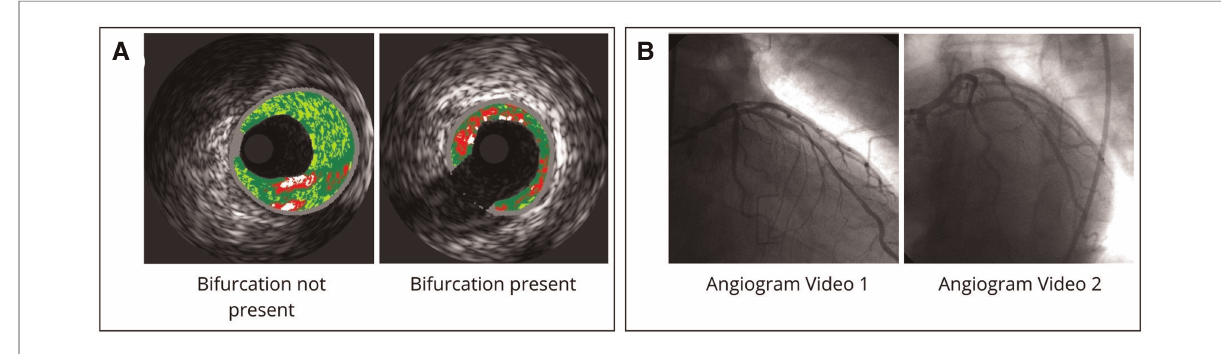
FIGURE 2 VH-IVUS and angiogram data. ( A ) Example of VH-IVUS images comparing bifurcated and non-bifurcated areas. ( B ) Angiogram data acquired from coronary angiography videos from two perspectives.